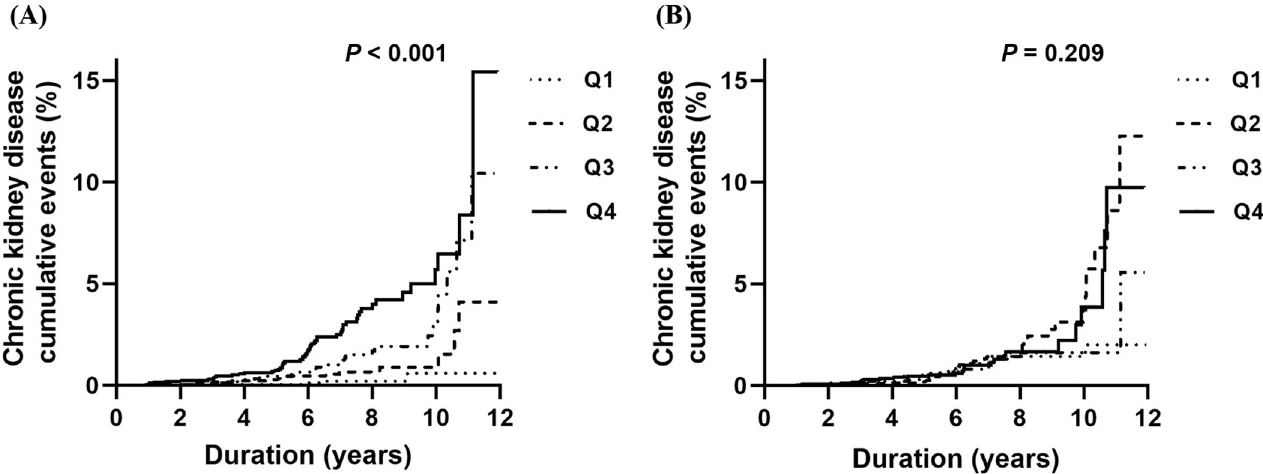
Fig 1. Probability of progression to chronic kidney disease according to the abdominal adipose tissue area. (A) Visceral abdominal fat area and risk of progression to chronic kidney disease. (B) Subcutaneous abdominal fat area and risk of progression to chronic kidney disease. Probability of CKD progression increased significantly when the visceral abdominal adipose tissue area was increased ( P < 0.001, log-rank test). CKD, chronic kidney disease.